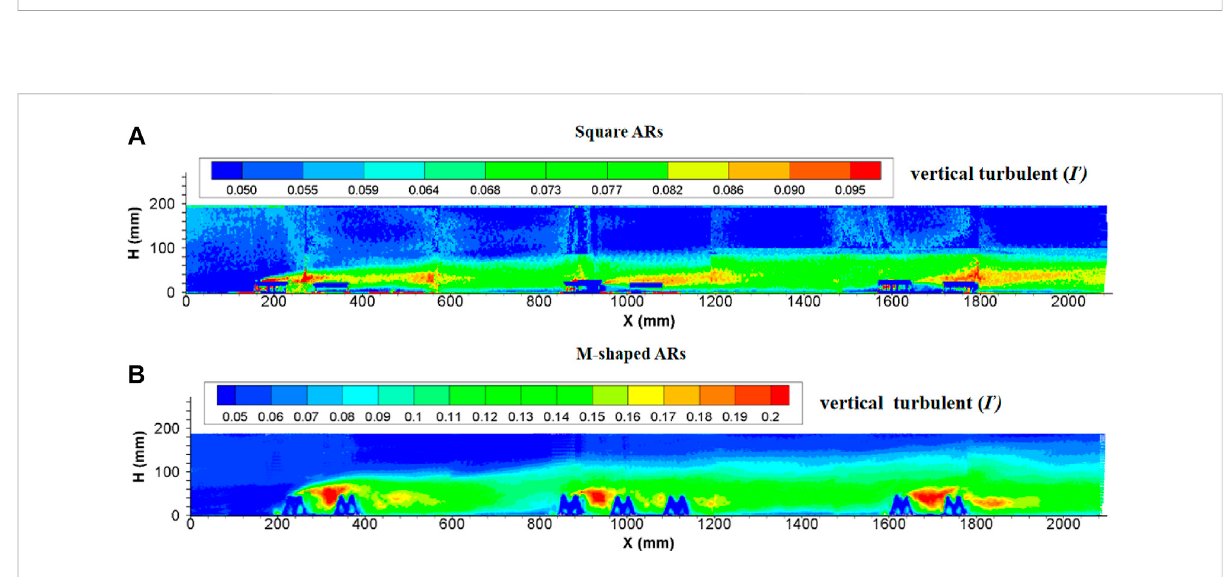
FIGURE 7 Sideviewoflongitudinalturbulenceintensityenhancedby (A) squareARsand (B) M-shapedARs(Shuetal.,2021c)underthesameexperimental